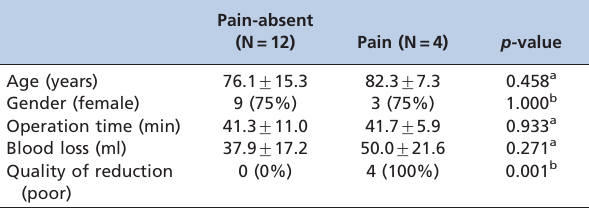
Table 2 - Factors that may be predictive of a ‘‘pain’’